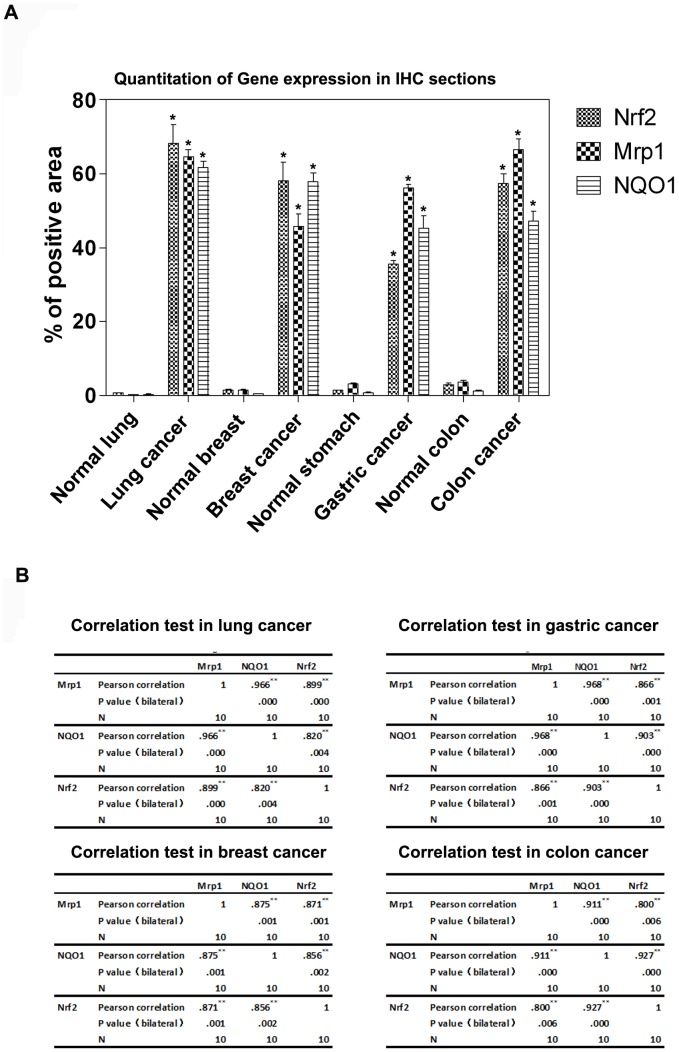
Statistical analysis of IHC data using i-Solution software.Five random visual fields were selected in each section and then were taken pictures of by camera. The pictures were analyzed by i-Solution software, and the positive area and the whole area of each picture were calculated. The protein level of Nrf2, Mrp1 and NQO1 was expressed as ratio of positive area to whole area. (A) The different expressing levels of Nrf2, Mrp1 and NQO1 in the four cancers were compared. (B) The correlation analysis was performed by SPSS between Nrf2, Mrp1 and NQO1 by twos.